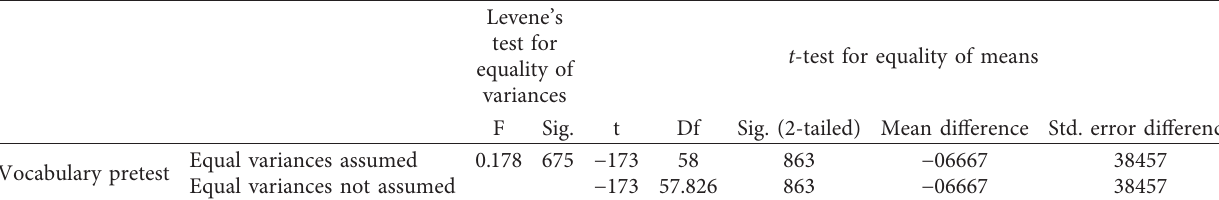
Table 2: Independent samples T -test (both groups’ pretest).